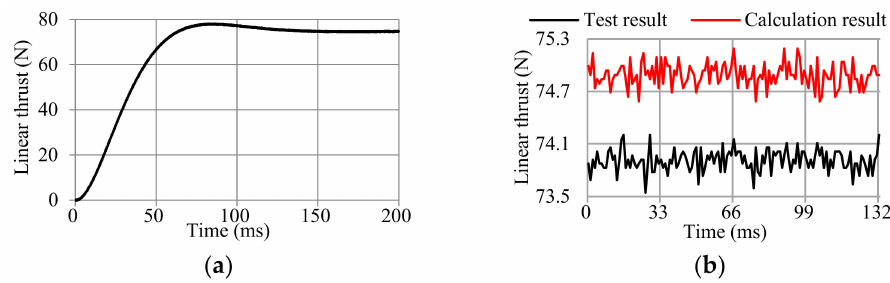
Figure 13. Transient thrust features: ( a ) thrust step response, ( b ) stable